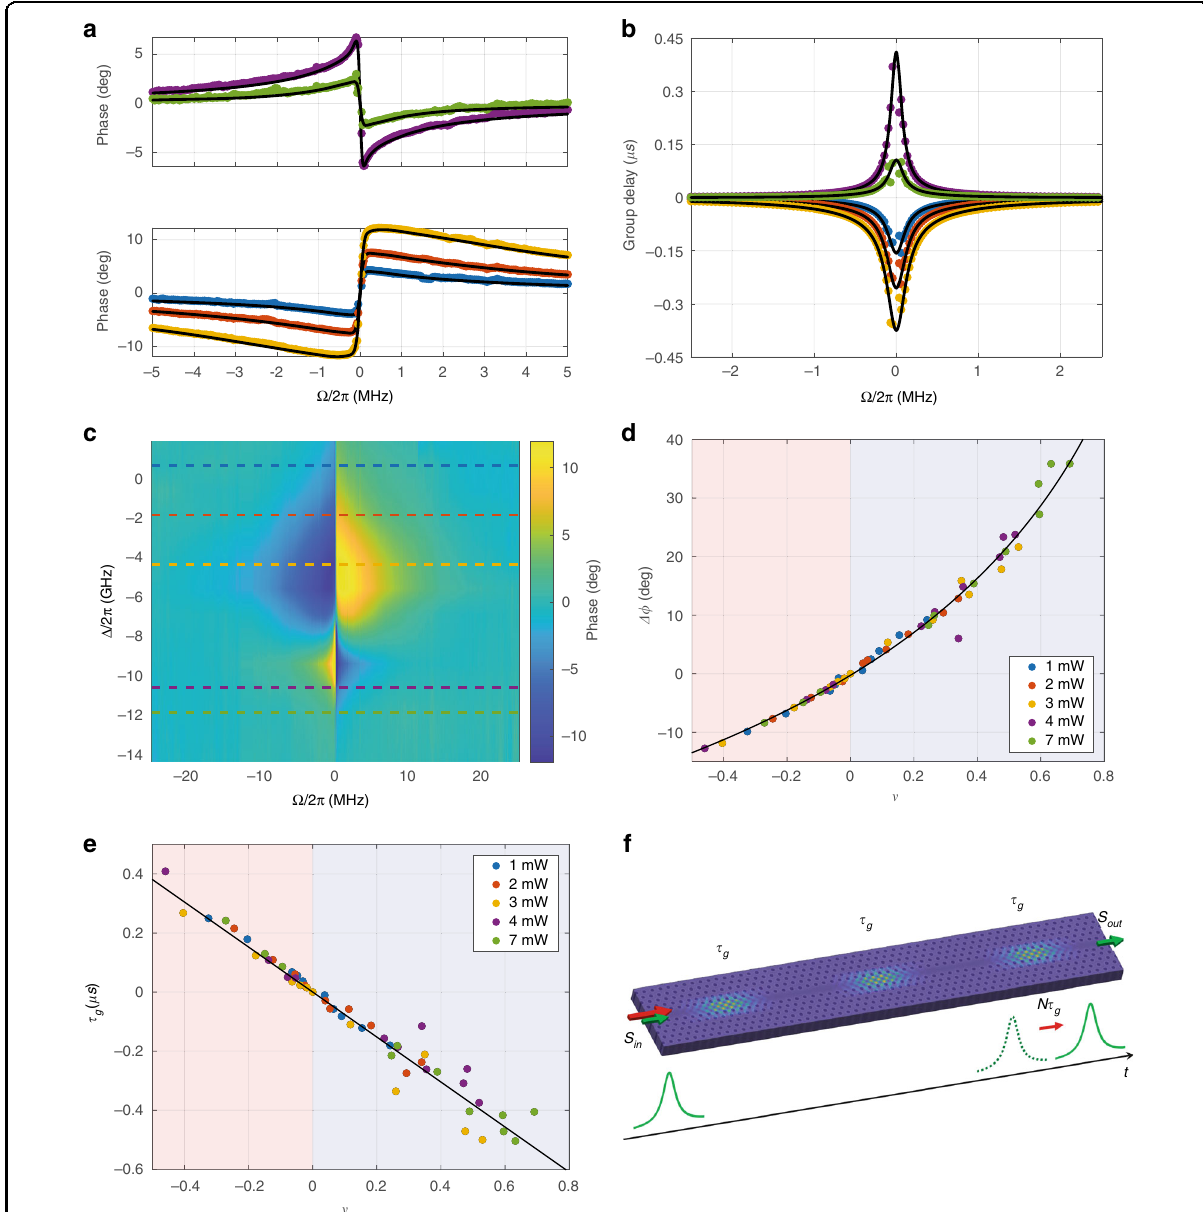
Fig. 3 Phase response. a Probe phase spectra as a function of the control-probe detuning frequency, Ω . The experimental data (dots) and model fi t (black curve) represent the phase trace associated to the amplitude response shown in Fig. 2a. Upper and lower panels correspond to red- and blue- detuning conditions, respectively. b Group delay traces obtained by numerical differentiation of data shown in a . c Color map of the measured phase as a function of the control-probe detuning frequency Ω and control-cavity detuning Δ = ω c − ω 0 , associated to the measurement shown in Fig. 2b. Horizontal slices correspond to experimental traces in a . d Maximum phase shift and e peak group delay (advance) as a function of V . The blue (red) region corresponds to the absorption (ampli fi cation) regime. Black curves are model fi t to data. f Conceptual scheme for cascaded TOIT. The group delay τ g induced by the N microcavities sums to the overall value N τ g , overcoming the time-bandwidth limit which holds for the single